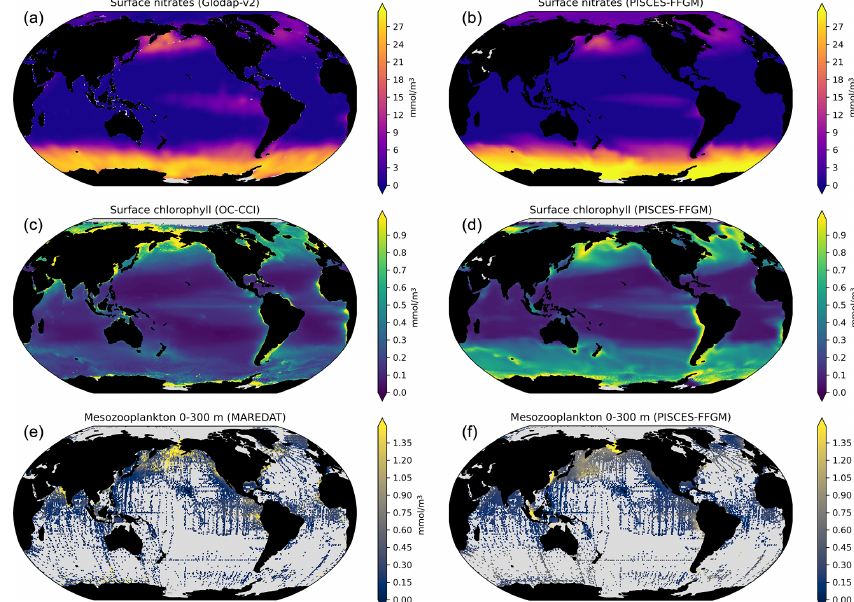
Figure A3. Comparison between modeled and observed annual average surface nitrates (a, b) , surface chlorophyll (c, d) and mesozoo- plankton biomass integrated over the top 300m (e, f) . The mesozooplankton field (mmolm − 3 , vertically integrated between 0 and 300m) from MARine Ecosystem DATa (MAREDAT) (Moriarty and O’Brien, 2013) is used to evaluate our modeled total mesozooplankton biomass distribution. The PO 3 − and NO − surface fields from the World Ocean Atlas (Garcia et al., 2019) are used to evaluate our modeled nutrient 4 3 distributions. The long-term multi-sensor time series OC-CCI (Ocean Colour project of the ESA Climate Change Initiative; Sathyendranath et al., 2019) for satellite phytoplankton chlorophyll a sea surface concentration converted into mmolm − 3 is used to evaluate our modeled total chlorophyll distribution.